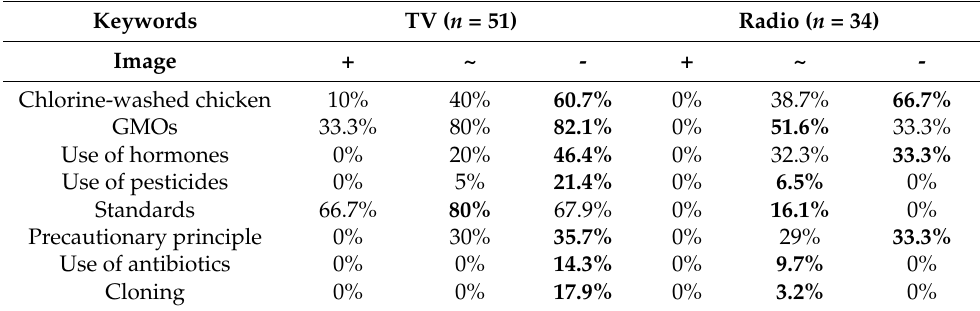
Table 3. Percentage allocation and percentage frequency of the naming of examined keywords of